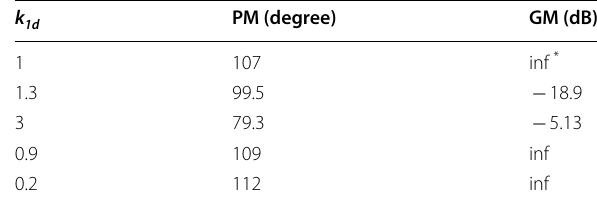
Table 6 GM and PM of the RSC control circuit using FFOADRC (for k 1, α 0.7, ω 10, and different k 2d = c = =